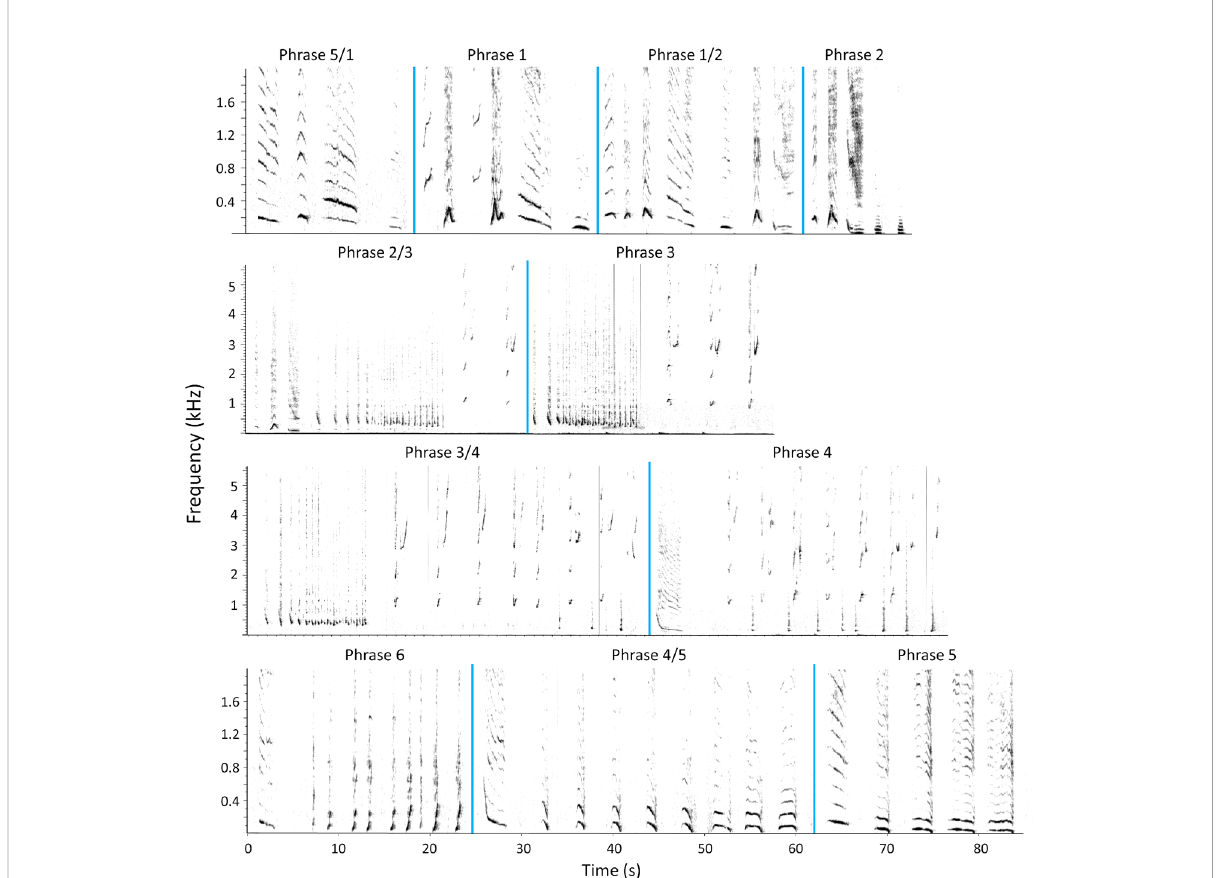
FIGURE 6 Humpback whale song type encountered in spring 2018 at Challenger Bank, Bermuda. A representative phrase for each theme and transitional phrase (/) is shown. The phrases are in cyclical order 5/1-1-1/2-2-2/3-3-3/4-4-6-4/5-5. Phrase 6 did not occur in every analysed song cycle. The vertical blue lines indicate divisions between phrase types. Spectrogram parameters: fast Fourier transform (FFT) size = 2048 points, overlap = 75%, sample rate = 16000 Hz, frequency resolution = 7.8 Hz and time resolution = 32